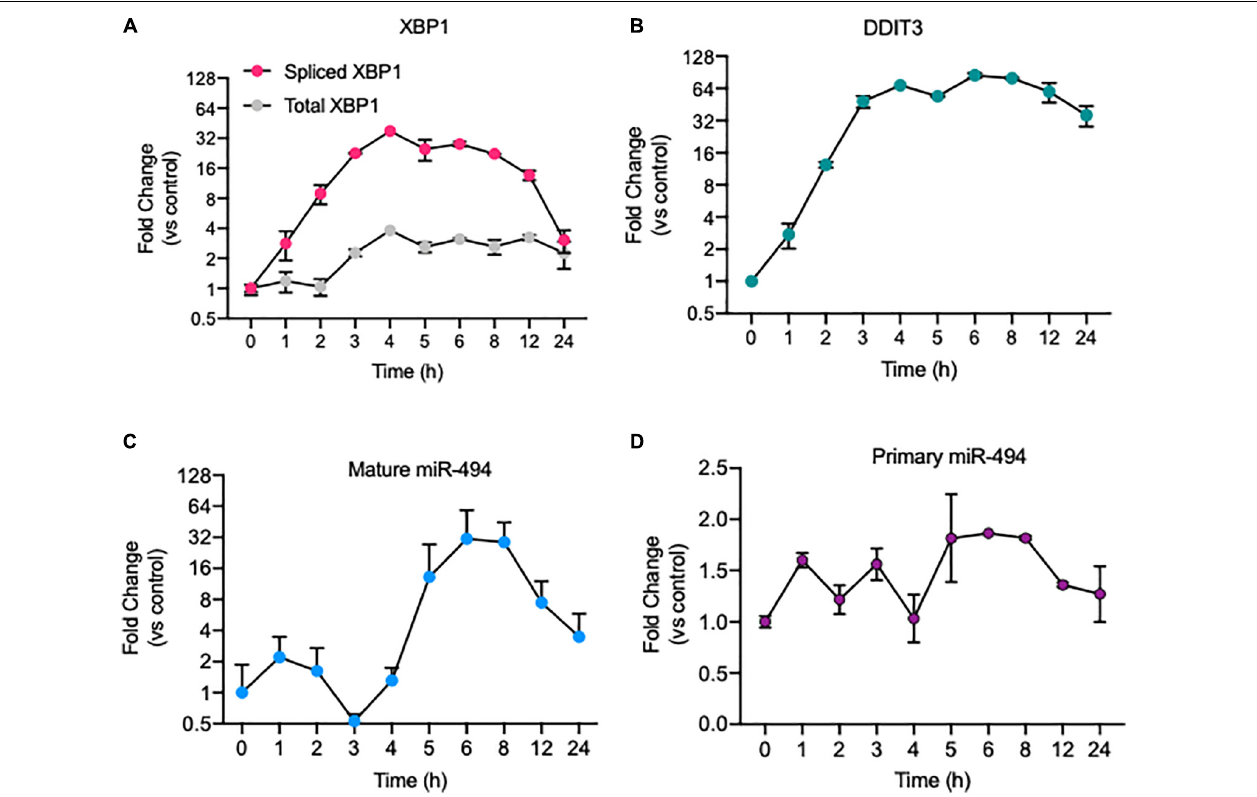
FIGURE 1 | ER stress induces expression of the primary and mature forms of miR-494. Relative mRNA expression of ER stress responsive genes as measured using qRT-PCR. (A) spliced XBP1 and Total XBP1 and (B) DDIT3 (CHOP) mRNA levels in HUVECs treated with 5 µ g/mL tunicamycin (TCN) over a time course. Relative expression of (C) mature miR-494 and (D) primary miR-494 (pri-miR-494) in HUVECs treated with TCN over a time course. Gene expression is normalized to GAPDH or U6 and mean fold change compared to vehicle control or time 0h is shown. Graphs are representative of one biological replicate from three independent replicates where values indicate mean ± standard